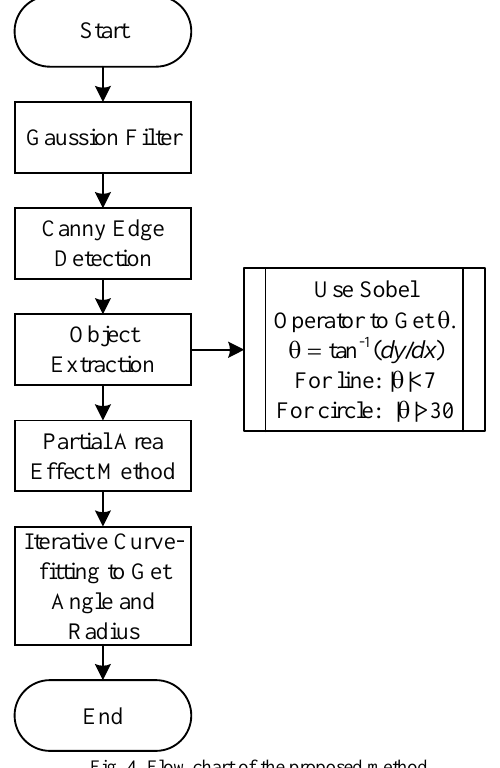
Fig. 4. Flow chart of the proposed method.